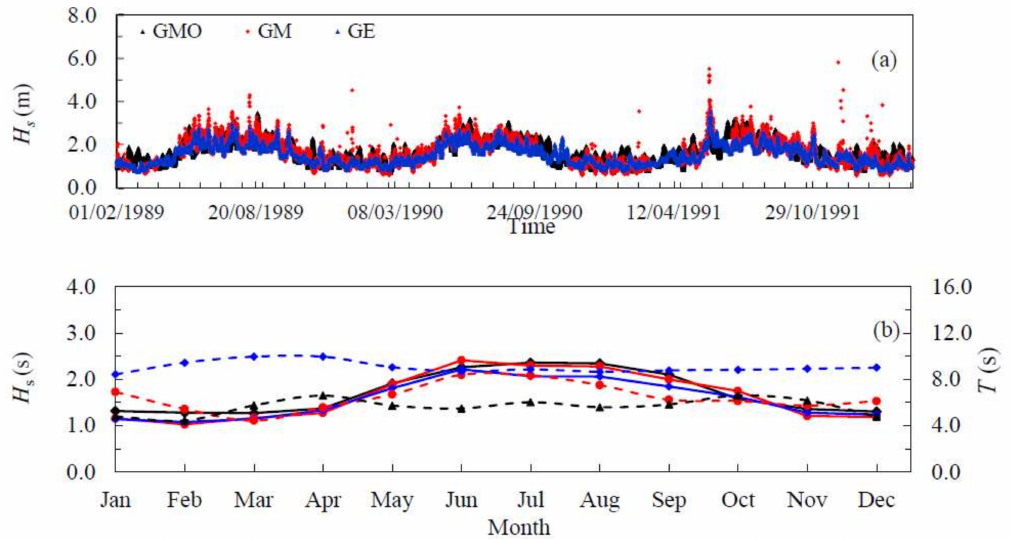
Figure 4. A comparison of simulated (GMO-black), ERA Interim Reanalysis (GE-blue) and measured (GM-red) waves. [GMO-(5.931 ◦ N 80.232 ◦ E); GE-(6 ◦ N 80.25 ◦ E); GM-(5.93 ◦ N 80.23 ◦ E)]. ( a ) Time series of significant wave height H s ; ( b ) Monthly averaged H s and wave period T ( T m02 for GM and GMO. Mean wave period for GE). Time averaging was done using 3 years data between 1989 and 1992. H s —dark lines, T —broken